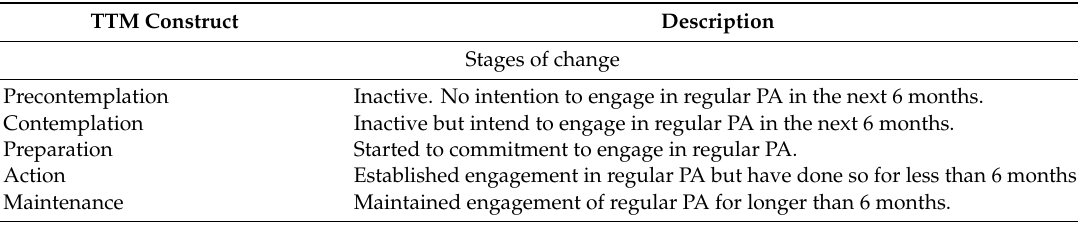
Table 1. Transtheoretical Model (TTM). Description of each